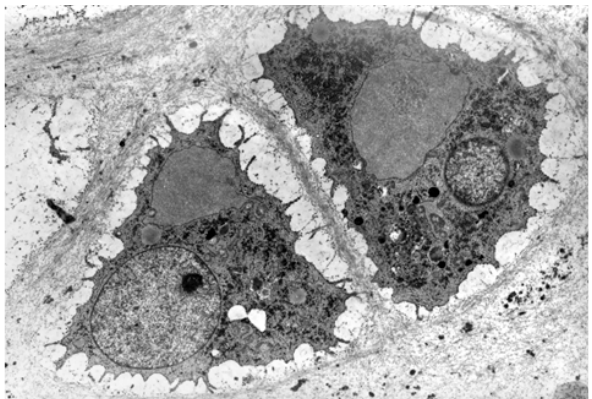
Fig. 12. Electron microscopy picture from conventional chon- drosarcoma shoving usual neoplastic chondrocytes surrounded with normal thin capsule, containing only fibrillar component. Original magnification